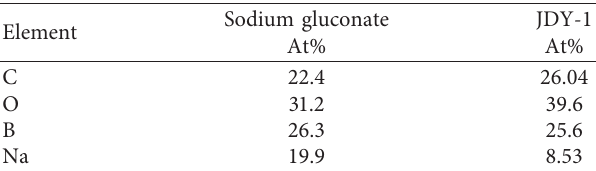
Table 3: Elementary analysis test results of cross-linkers.